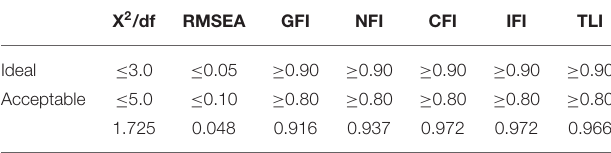
TABLE 5 | Goodness of fit index (GFI).